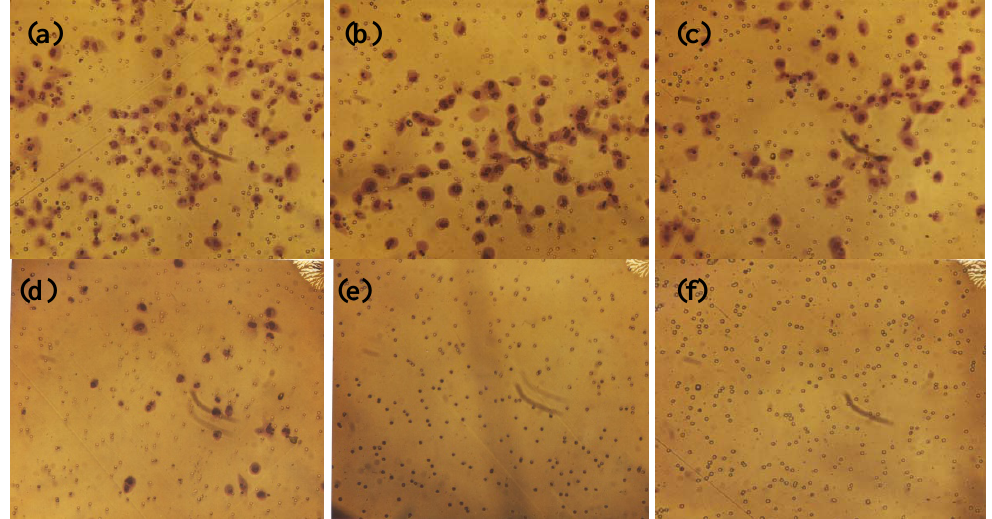
Figure 5. Comparative effect of EGCG with and without LPA on HepG2 cell invasion through Matrigel: photomicrographs ( a ) Control no LPA, ( b ) Control with LPA, ( c ) EGCG